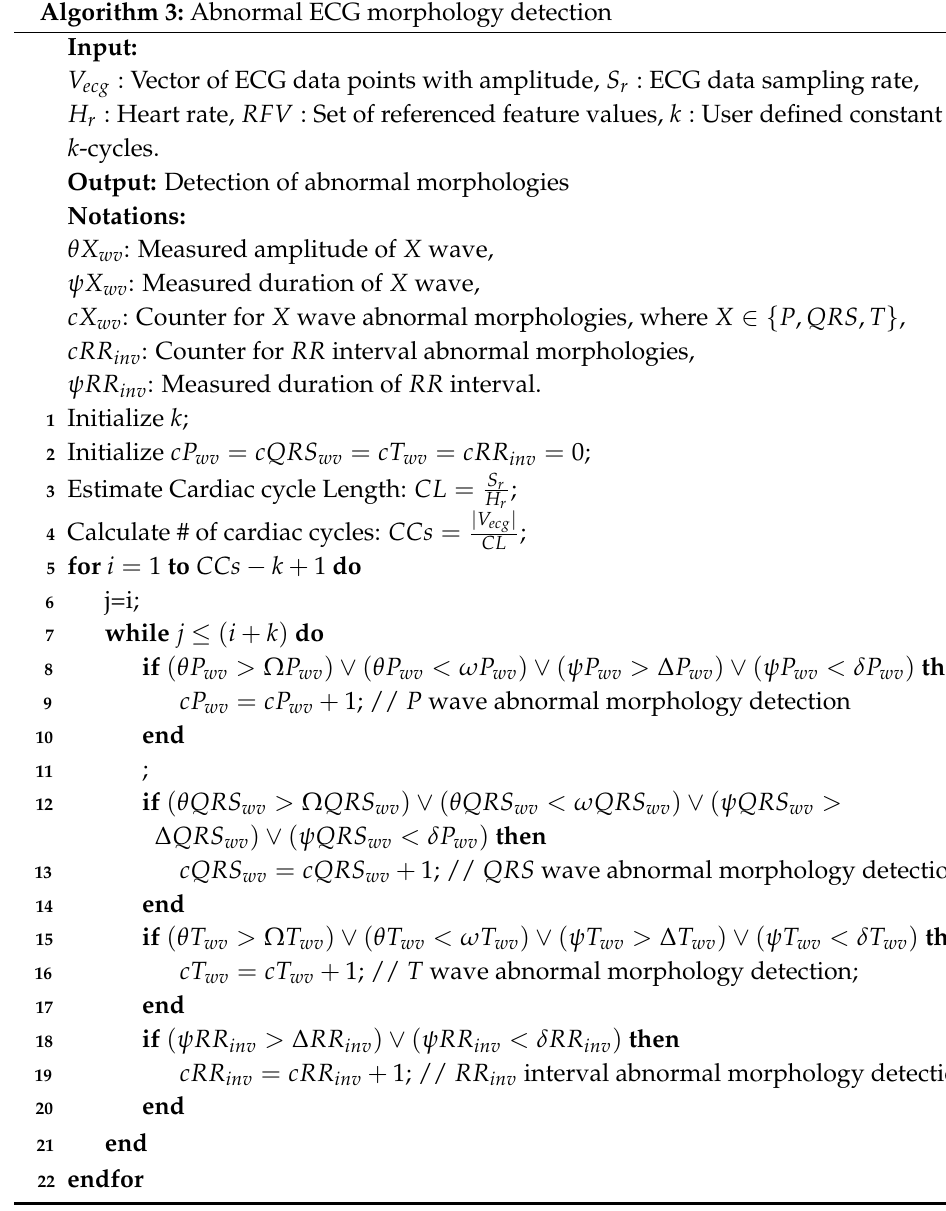
Algorithm 3: Abnormal ECG morphology